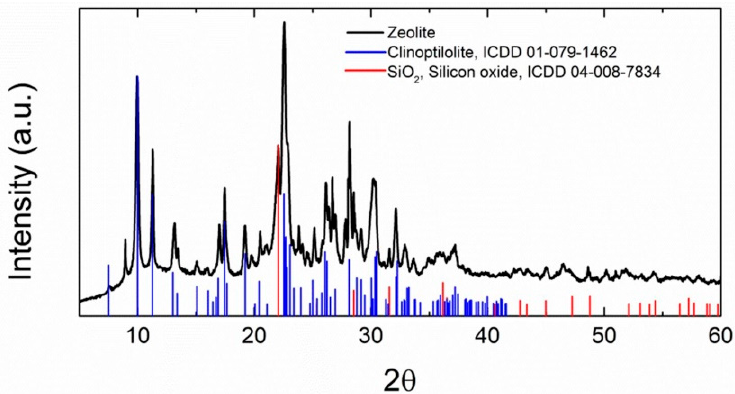
Figure 1. Diffraction pattern of zeolite.